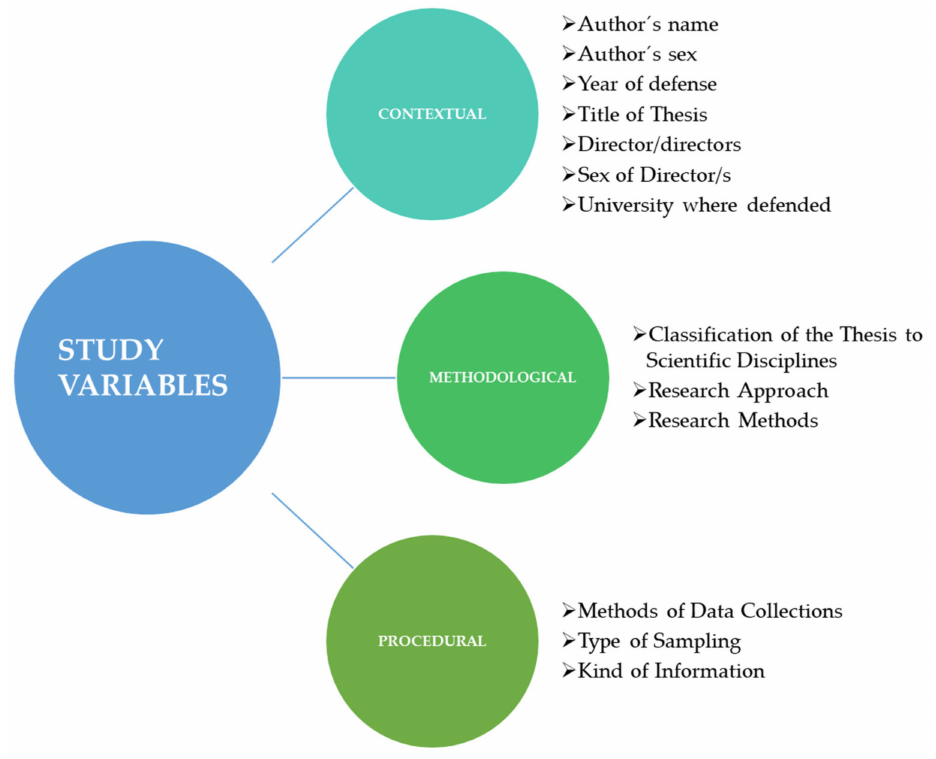
Figure 2. Diagram of the grouping of the study